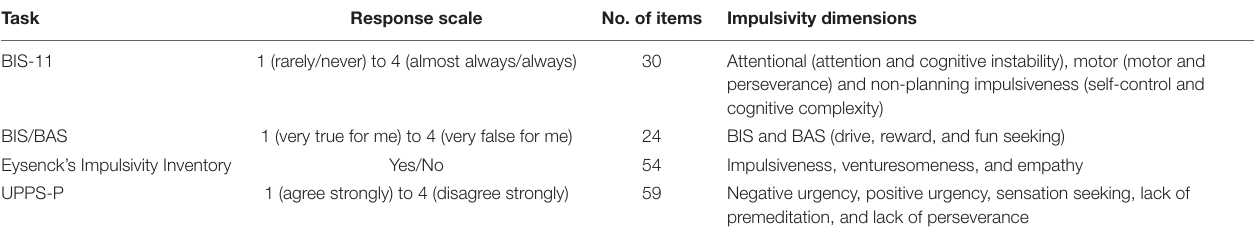
TABLE 2 | Self-reported measures of